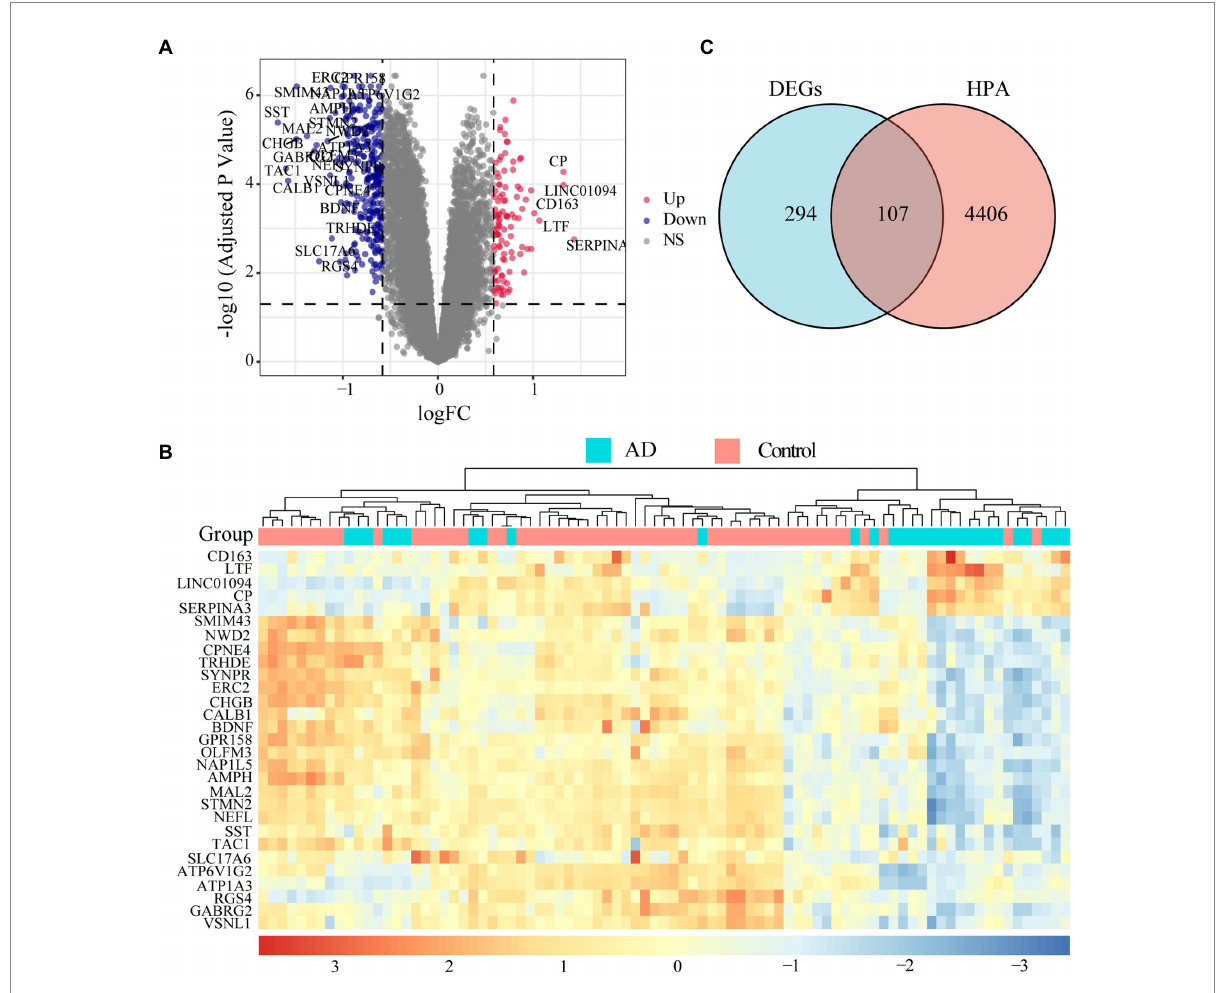
FIGURE 3 Landscape of differentially expressed genes (DEGs). (A) Volcano map of DEGs. Red dots represent up-regulated differential genes, blue dots represent down-regulated differential genes, and grey dots represent no significant difference genes. The DEGs with |log 2 FC| > 1 and FDR < 0.01 are marked on the map. (B) An expression heat map of DEGs with |log 2 FC| > 1 and FDR < 0.01. (C) The genes related to disease annotated in the HPA database were intersected with DEGs, 107 AD-related DEGs were screened